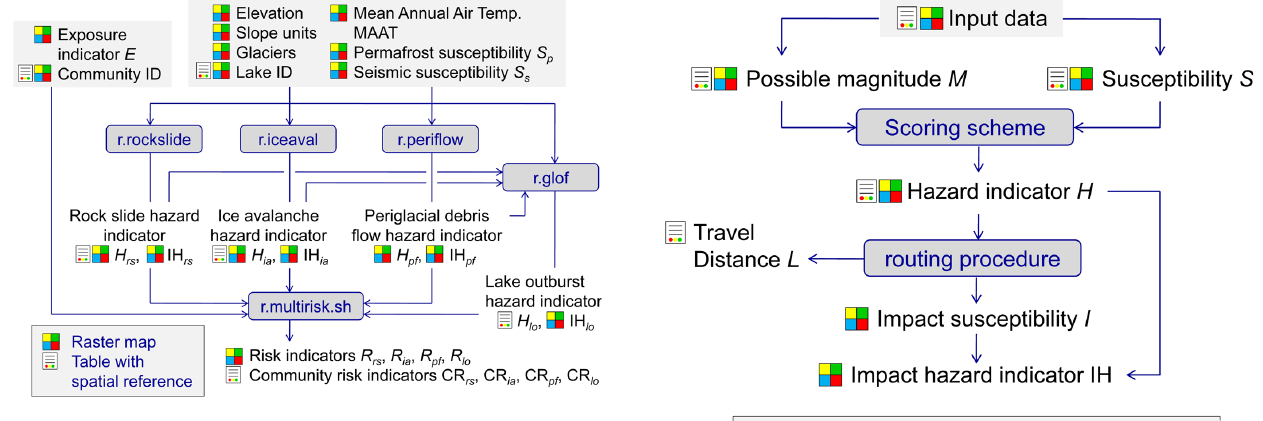
Fig. 4. Logical framework of the high-mountain multi-hazard and -risk indicator model.